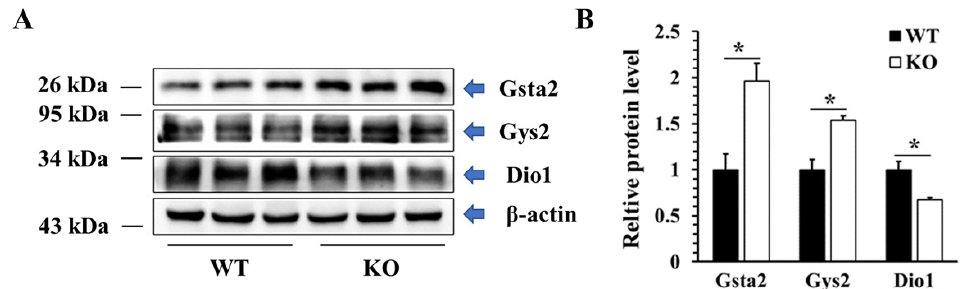
Figure 12. Validation of DEPs at the protein level. Representative western blot ( A ) and quantified data ( B ) of selected DEPs in WT and KO mice. Data were presented as the fold of the WT group and as means ± SEM ( n = 3). * p < 0.05; ANOVA followed by a Mann–Whitney nonparametric U